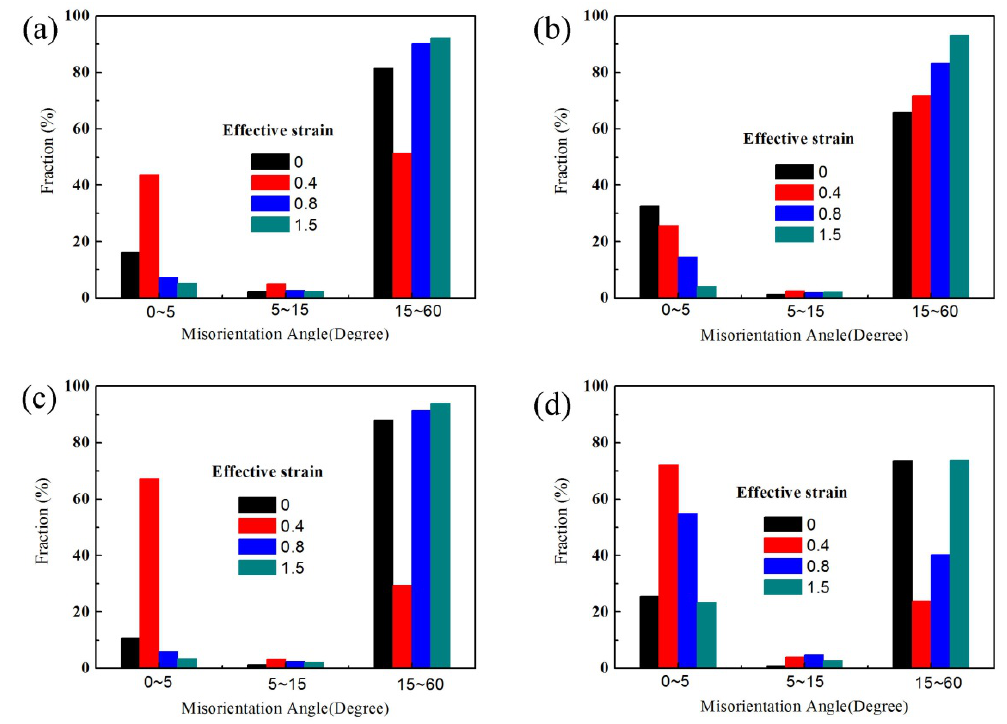
Figure 11. Misorientation angle distribution of the deformed alloy at: ( a ) 960 ◦ C, ( b ) 990 ◦ C, ( c ) 1010 ◦ C, ( d ) 1040 ◦ C.